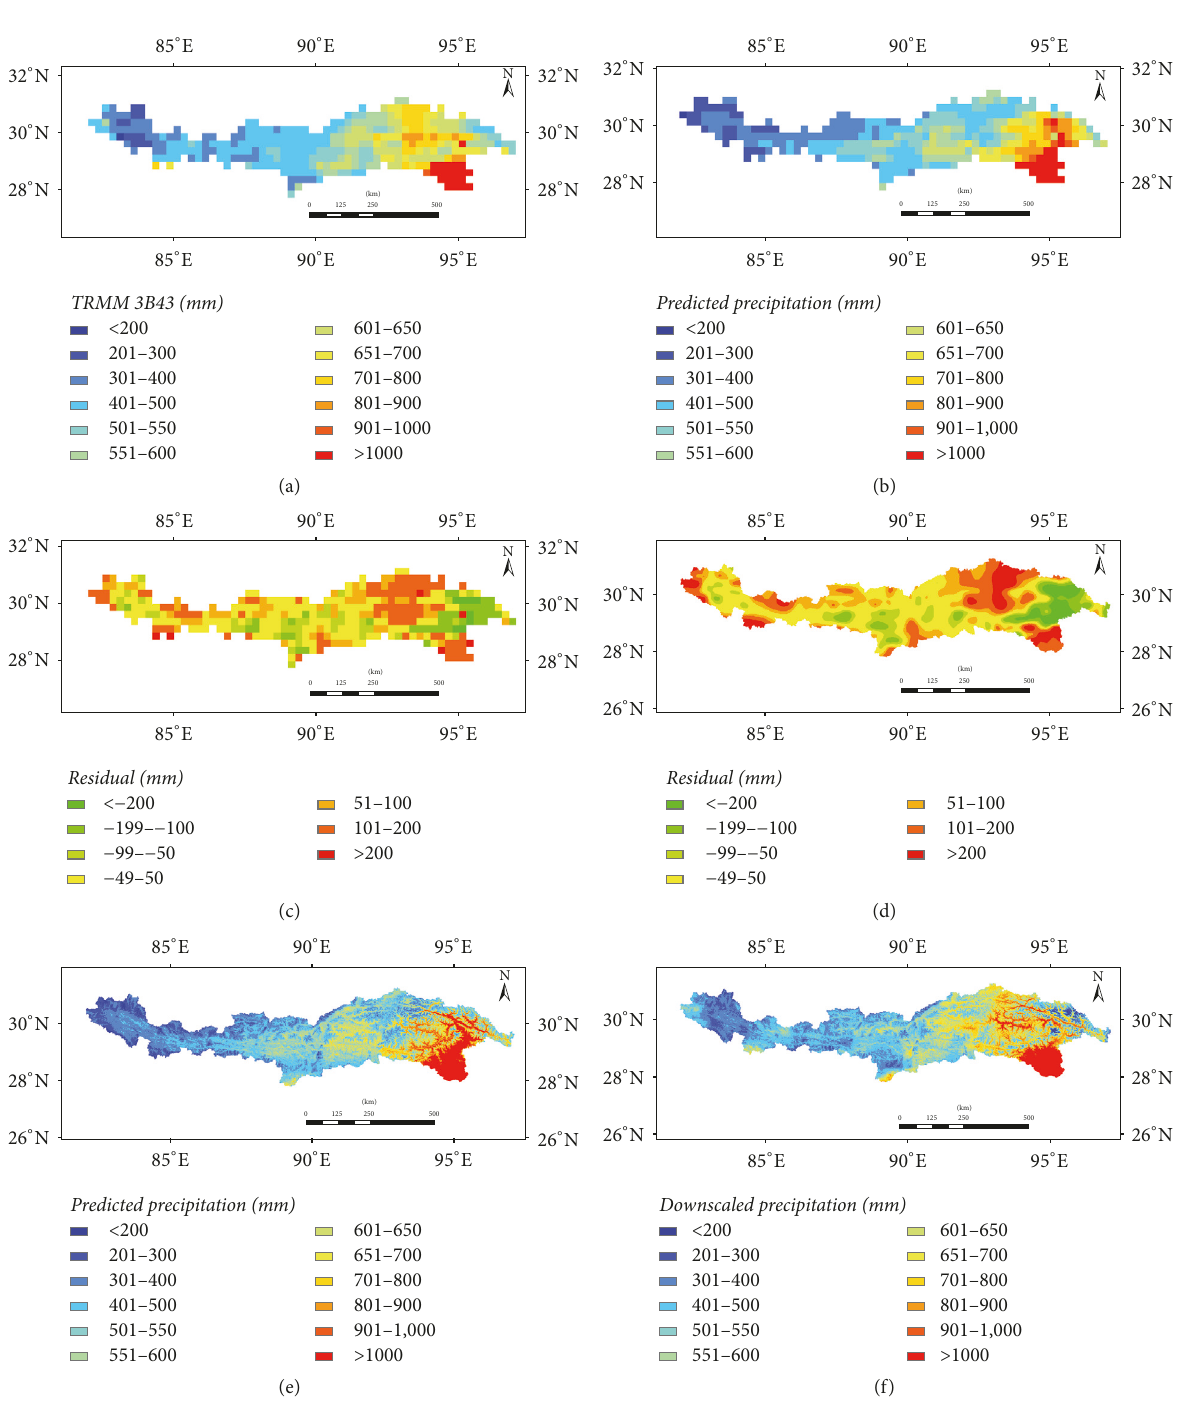
of 1 km × 1 km via spline interpolation using ArcGIS software (Figure 5(d)). The predicted annual precipitation (spatial resolution = 1 km × 1 km) was obtained by applying the